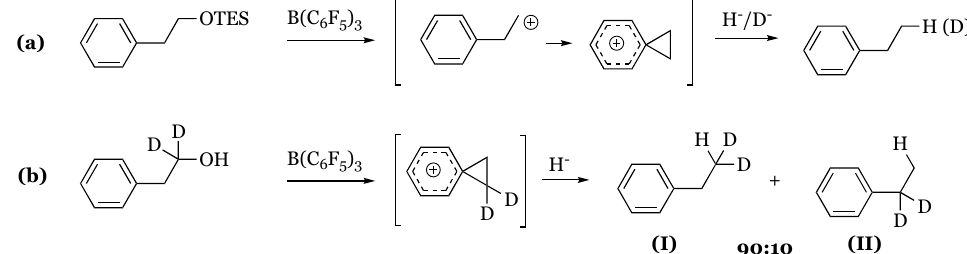
Figure 45. Postulated steps of reduction of: ( a ) phenylethanol-triethylsilyl ether via phenonium cation; ( b ) 1,1-dideuteriophenethyl alcohol via dideuteriophenonium cation (invalidated due to 90:10 product distribution).